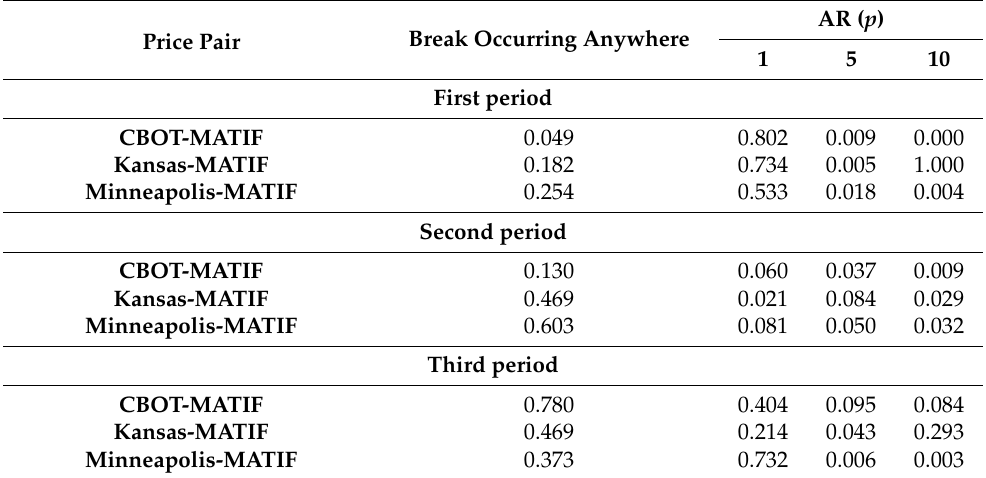
Table 8. Time-varying rank correlation between prices discovery.